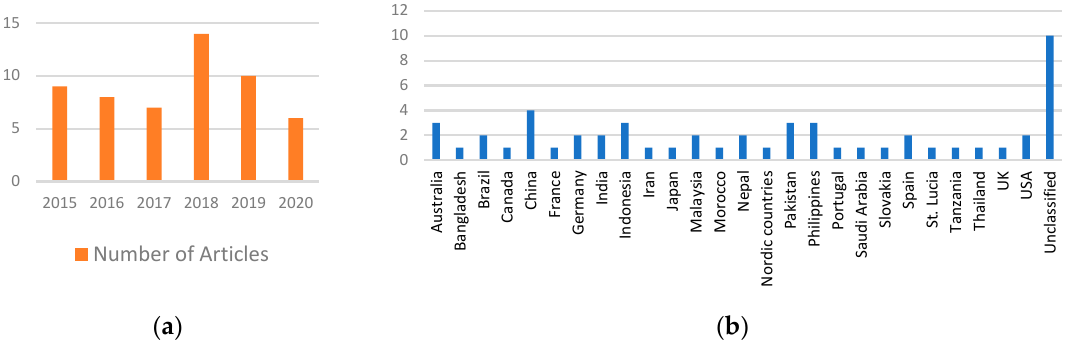
Figure 3. Distribution of articles based on ( a ) the year of publication and ( b ) the country of the case study.